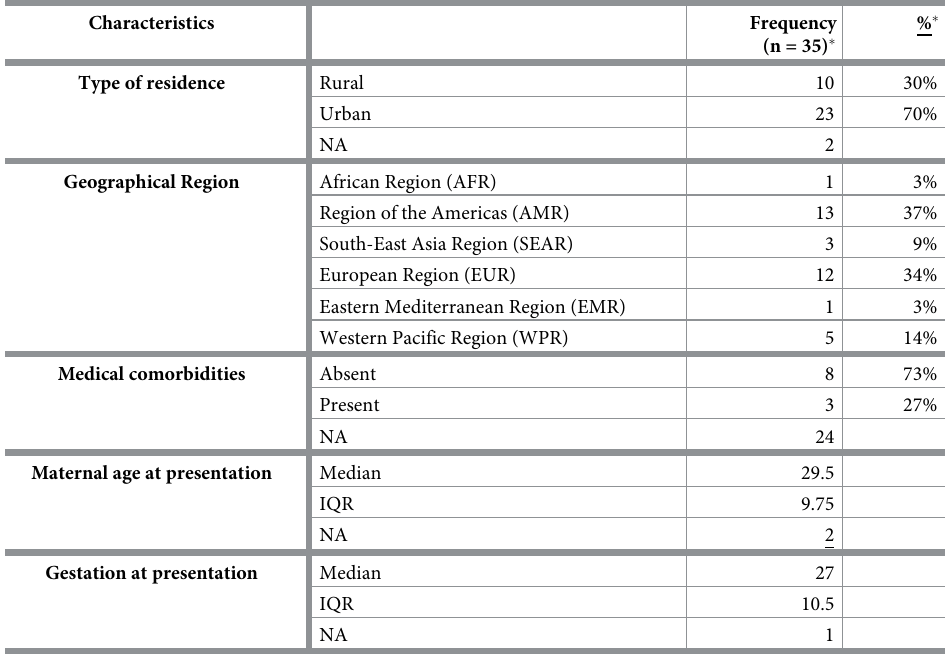
Table 4. Characteristics of patients with leptospirosis in